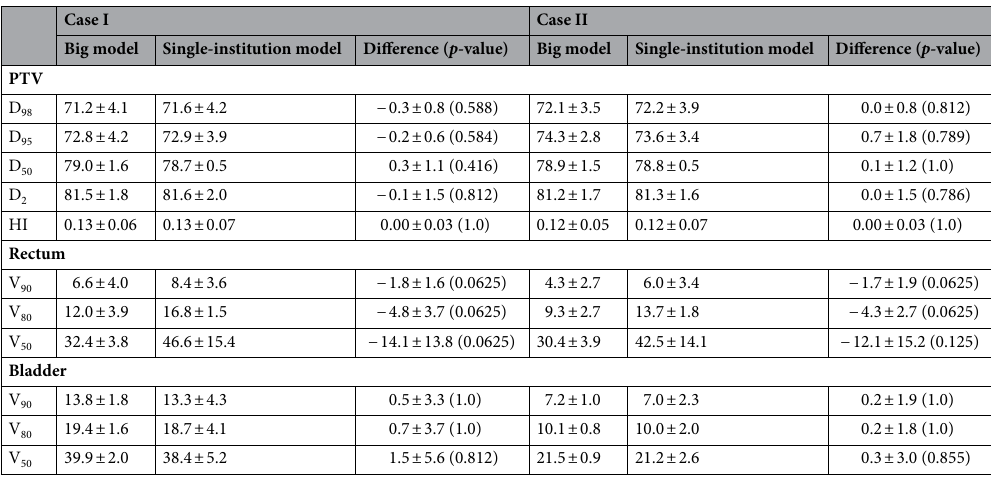
Table 3. Mean ± SD values of dosimetric parameters and differences between big model versus single- institution model.